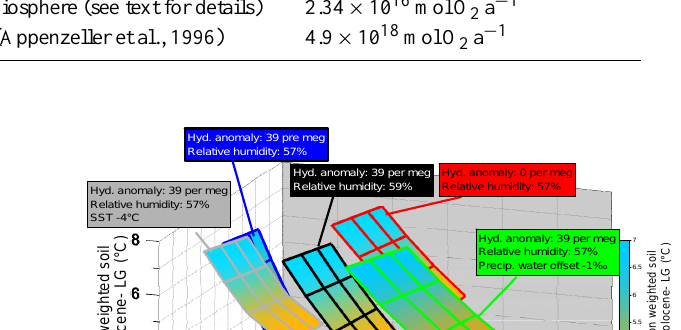
Gross photosynthetic oxygen flux from the land biosphere (see text for details)